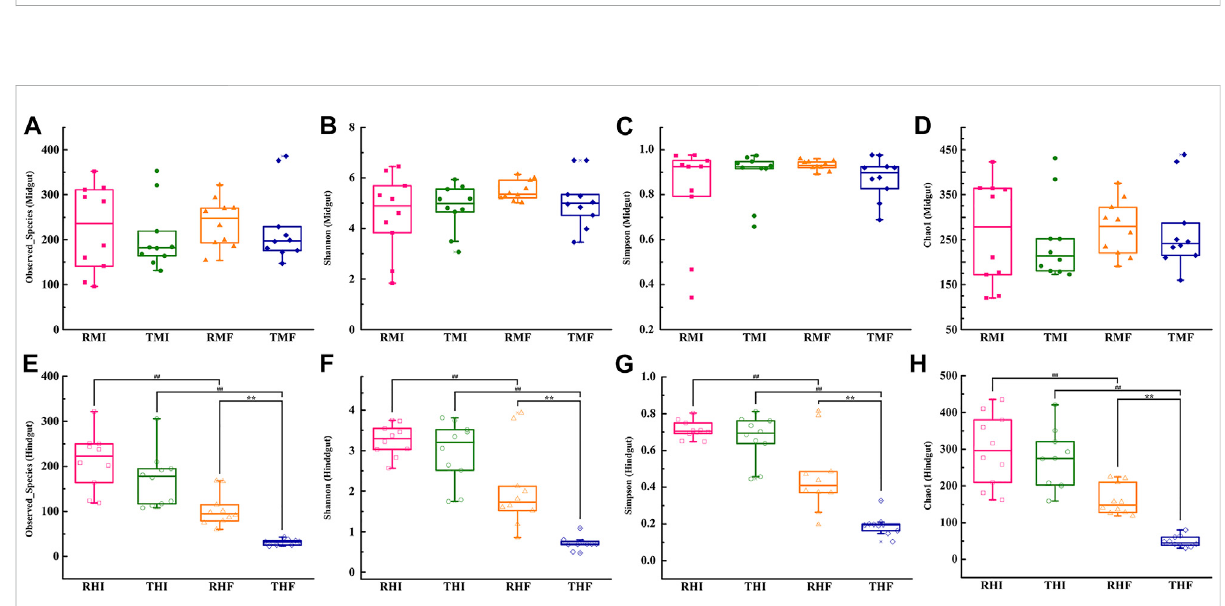
FIGURE 2 Alpha-diversitymeasurements ofgenetically improvedfarmed tilapia(GIFT)gutmicrobiota. (A) Observed species(midgut), (B) Shannon ’ sindex (midgut), (C) Simpson ’ s index (midgut), (D) Chao1 index (midgut), (E) Observed species (hindgut), (F) Shannon ’ s index (hindgut), (G) Simpson ’ s index (hindgut), and (H) Chao1 index (hindgut). The symbols ## and ** indicate signi fi cant differences in abundance between two groups (Mann – Whitney U -test; ** p < 0.01). For abbreviations, see caption to Figure